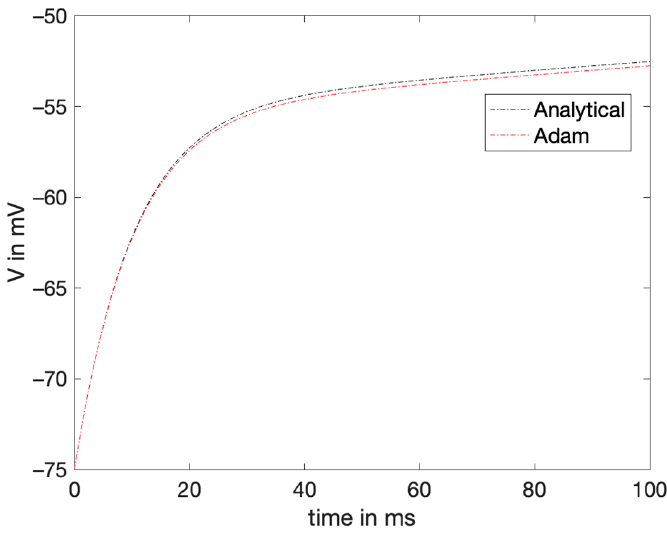
Figure 8. The estimated voltage from the AM4-AB4 method versus the exact voltage plotted when the current is also varying.